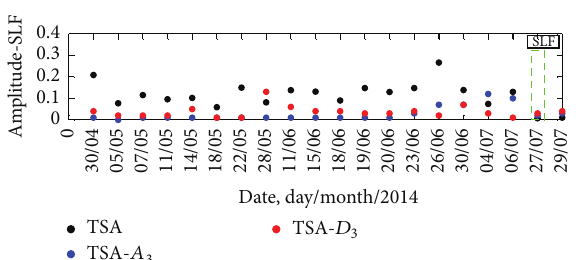
Figure 7: P2P over RDLT.